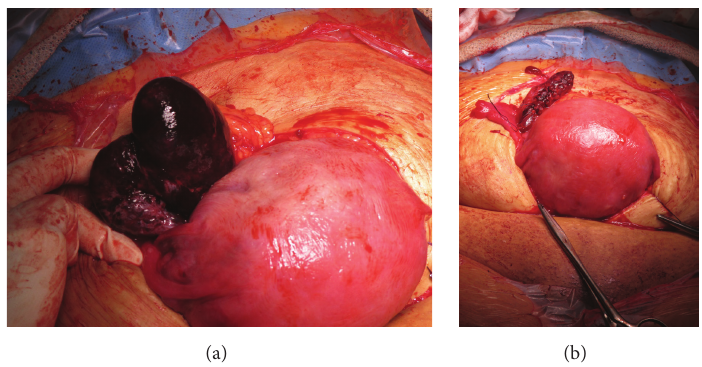
Figure 1: (a) Right ovarian cyst torsion. (b) Right ovary following resection of torted ovarian cyst.